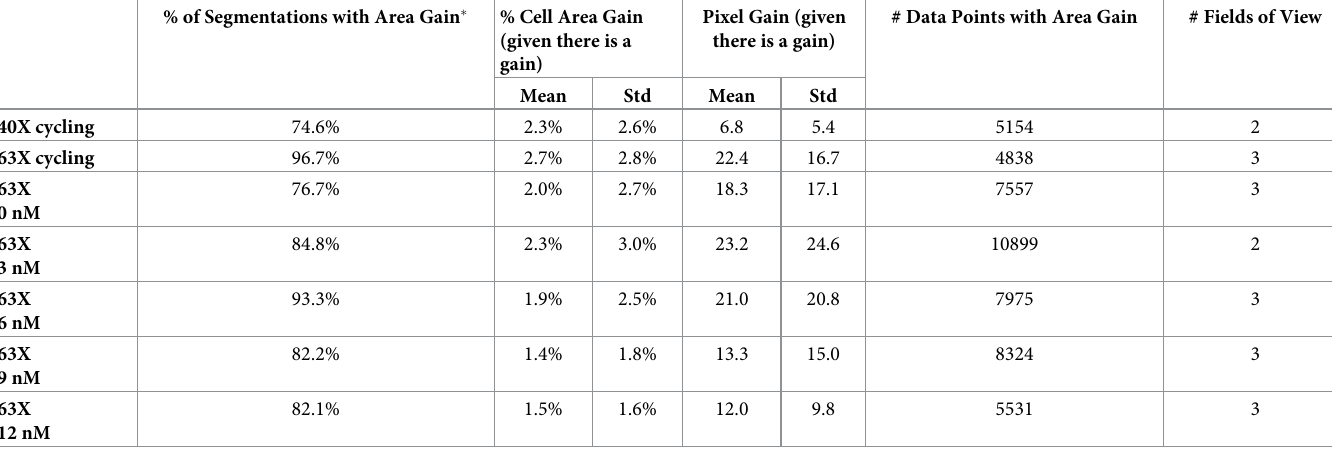
Table 2. Area gain by distribution of overlapping